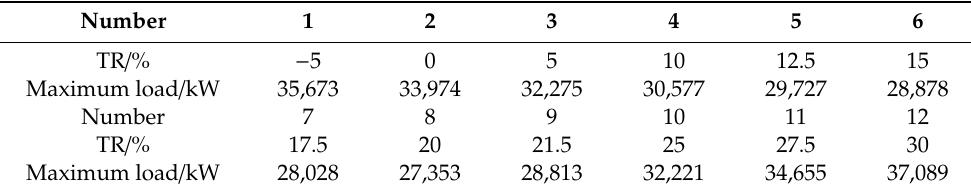
Table 1. Twelve di ff erent scenarios of load profiles due to load